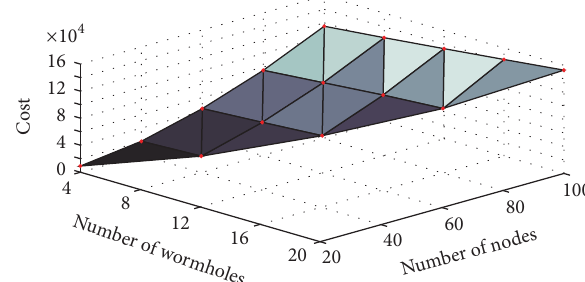
Figure 6: Detection cost in random